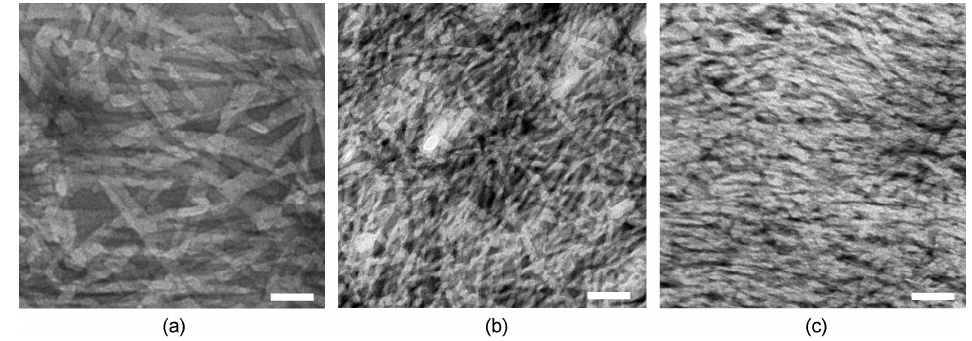
Figure 3. TEM micrographs of ( a ) peptide hydrogel, ( b ) peptide hydrogel with ketoprofen, and ( c ) peptide hydrogel with naproxen. Scale bar = 50 nm.